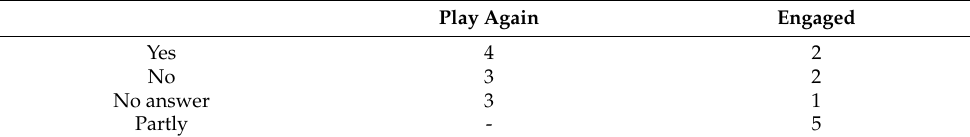
Table 5. Summary of the answers regarding re-playability and engagement.